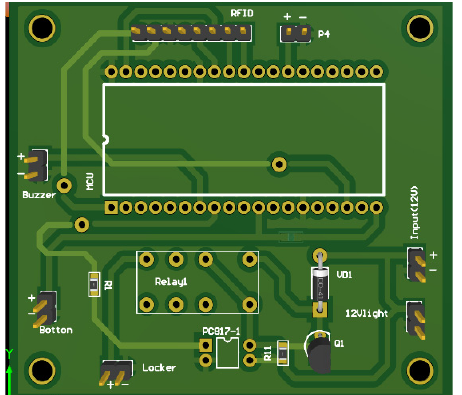
Figure 21. Circuit diagram of the control board of a sub-cabinet.